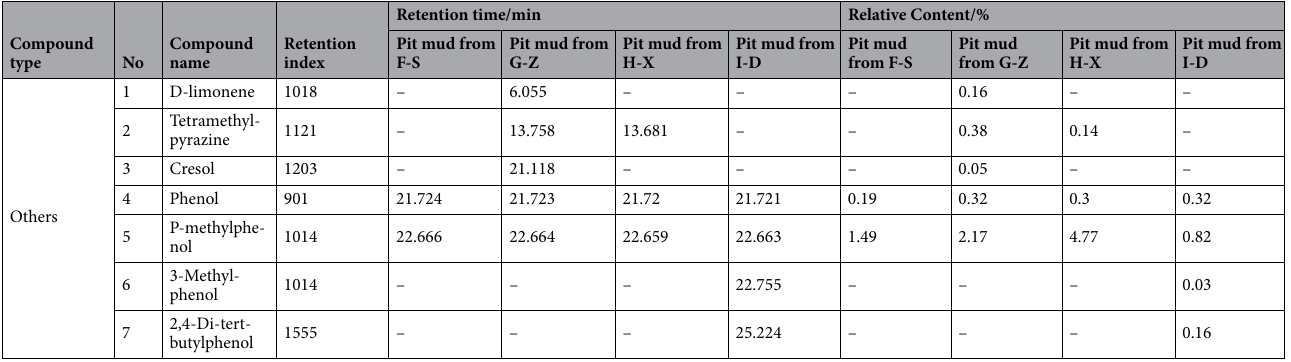
Table 2. Composition and content of volatile compounds in pit mud.